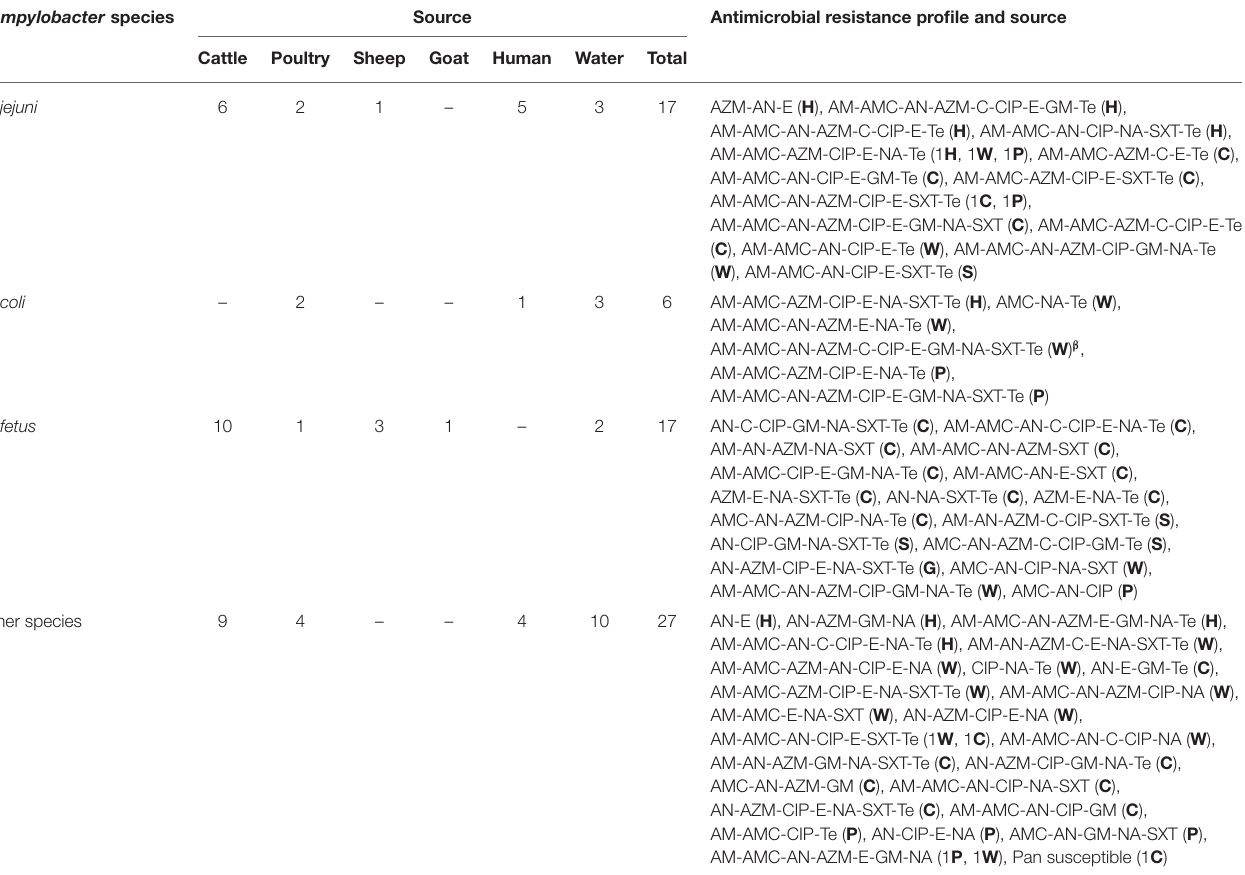
TABLE 7 | Antimicrobial resistance profiles of Campylobacter species isolated from animals, humans, and water in peri-urban Addis Ababa, Ethiopia. Campylobacter species